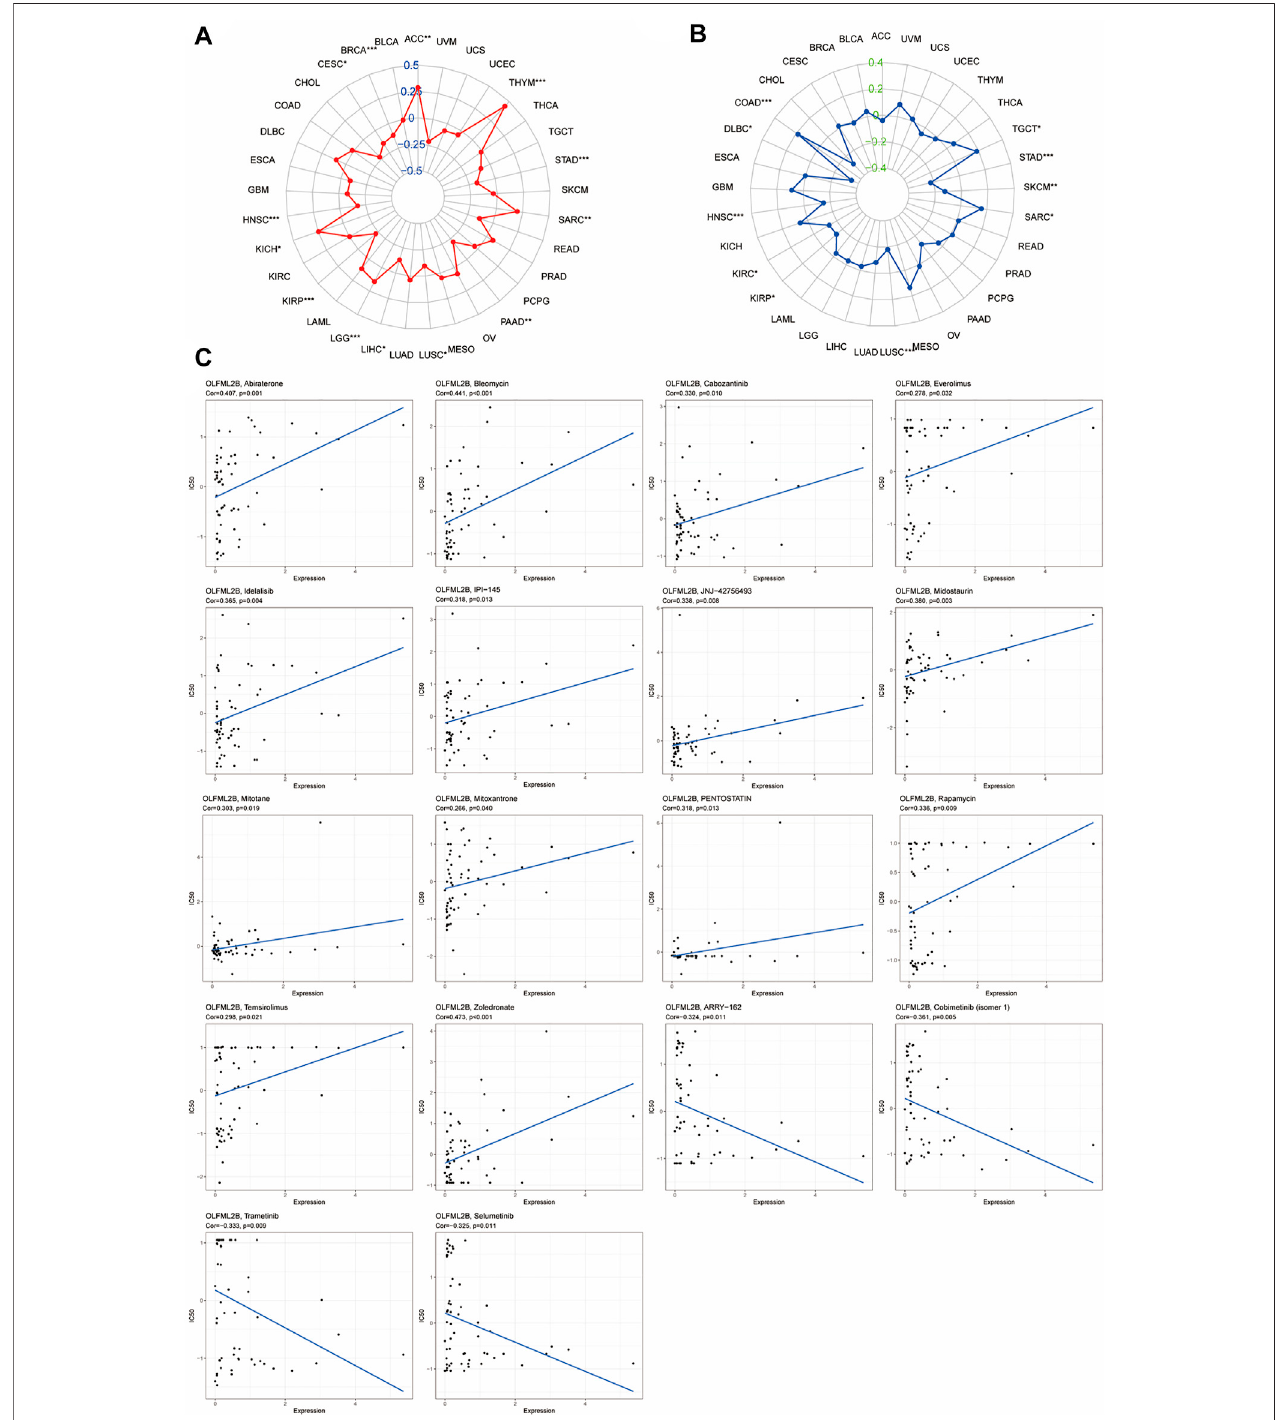
FIGURE10| CorrelationbetweenOLFML2BexpressionandTMB,MSI,anddrugsensitivity. (A) RadarmapofcorrelationbetweenOLFML2BandTMB. (B) Radar map of correlation between OLFML2B and MSI. (C) Correlation between OLFML2B expression and drug sensitivity.